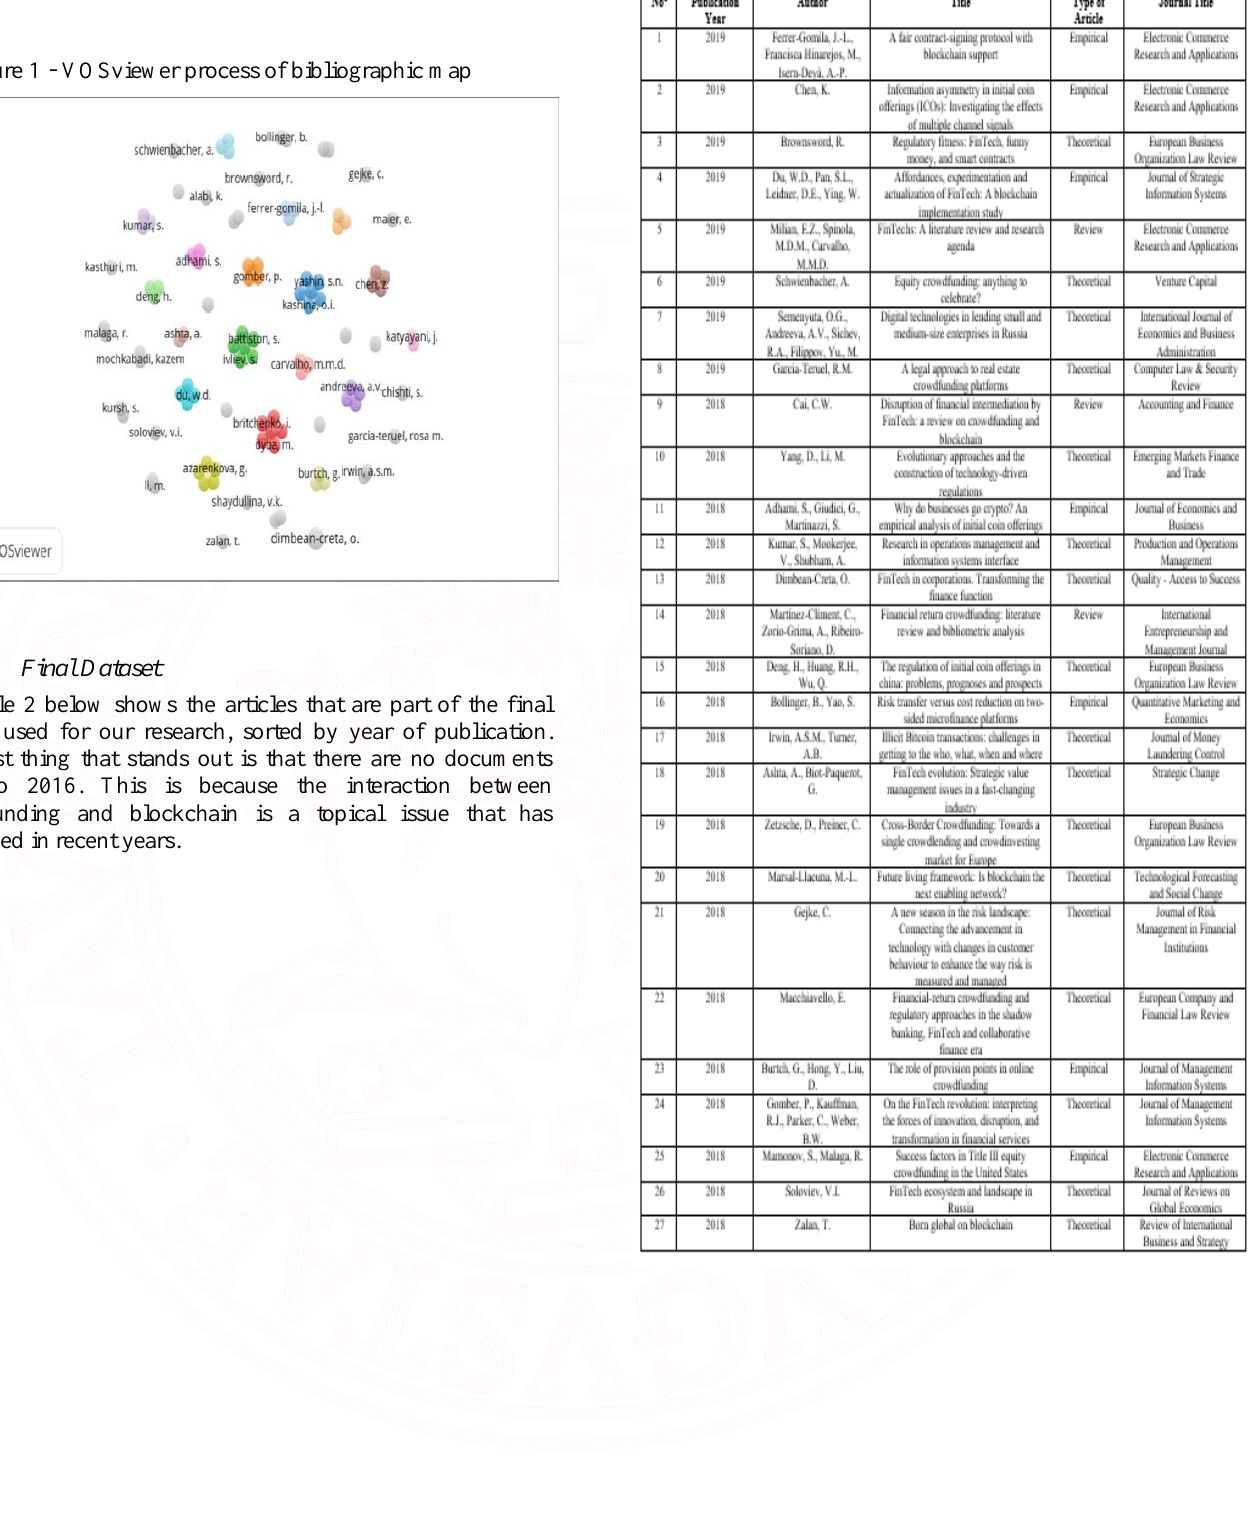
Figure 1 - VOSviewer process of bibliographic map